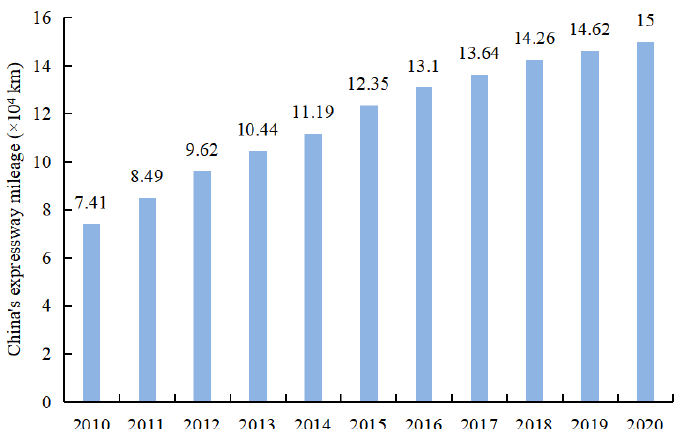
Figure 1. Evolution process of China’s expressway mileage from 2010 to 2020.